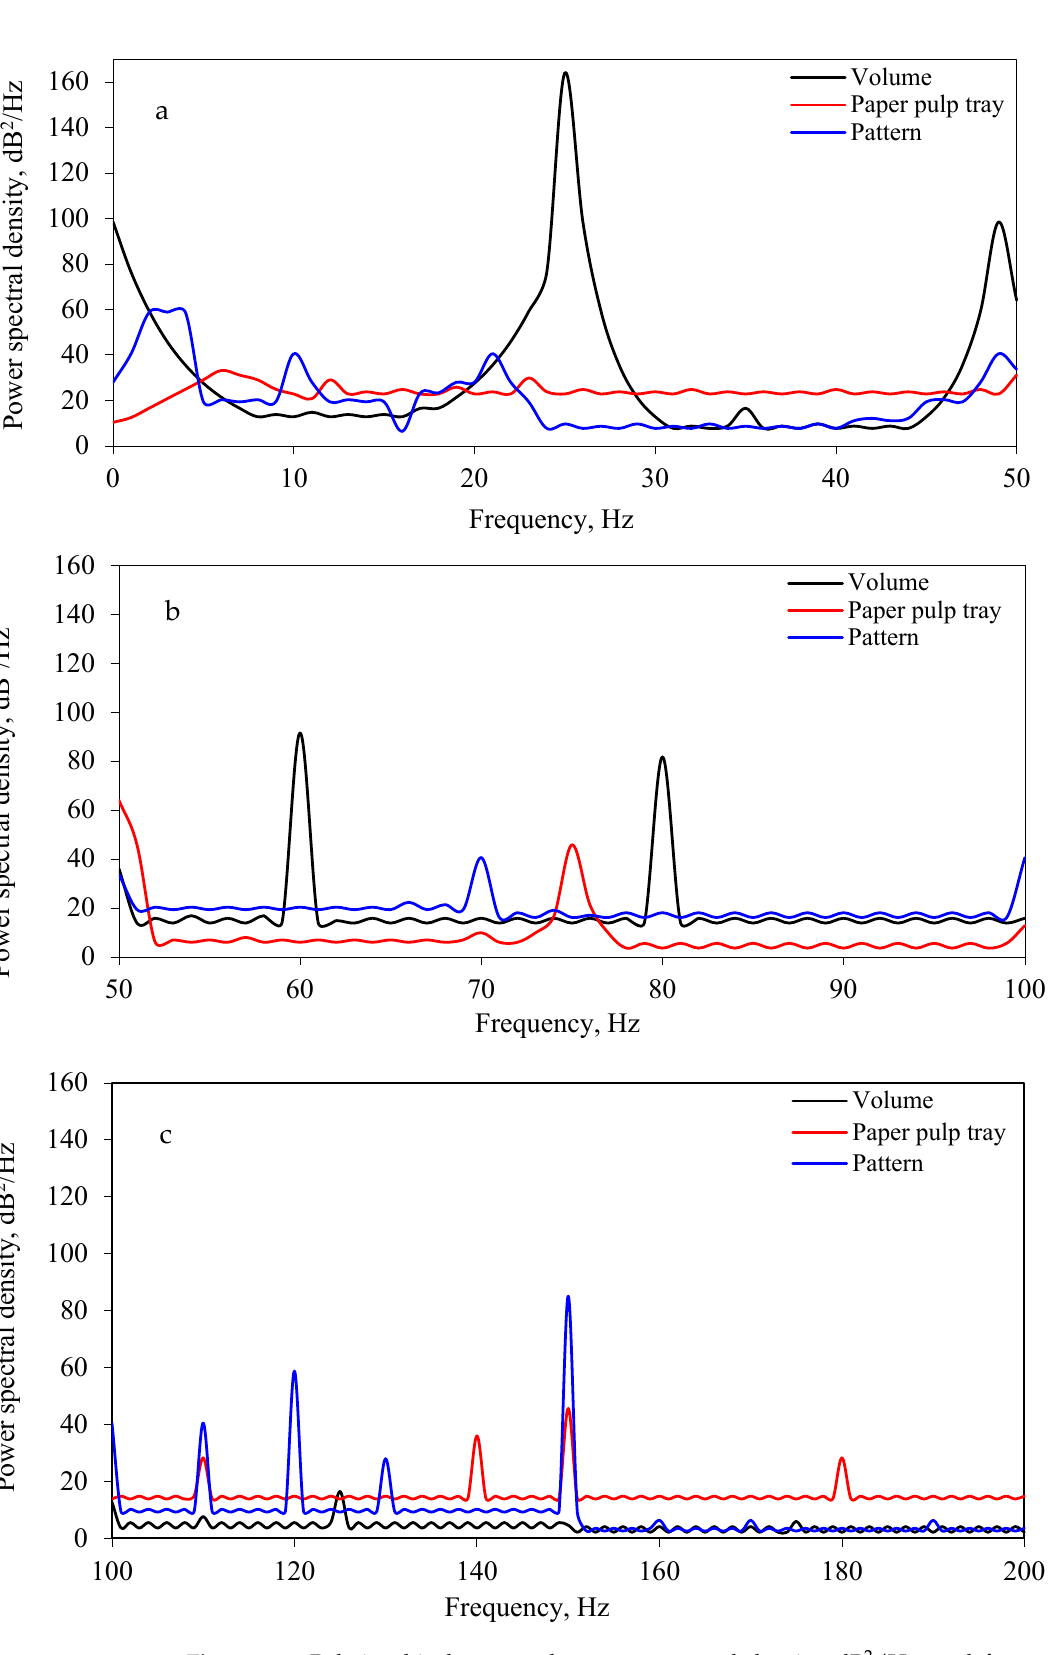
Figure 14. Relationship between the power spectral density, dB 2 /Hz, and frequency (Hz) of cantaloupe with different packing methods and a duration 10 min: ( a ) 0–50 Hz, ( b ) 50–100 Hz, ( c ) 100–200 Hz.